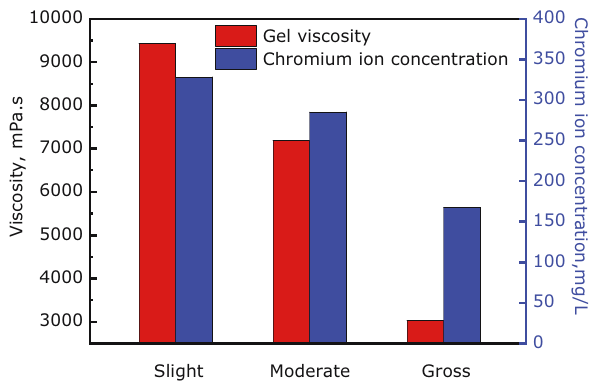
Figure 8: Relationship between gelling strength ( gel viscosity ) and chromium concentration at di ff erent leak o ff